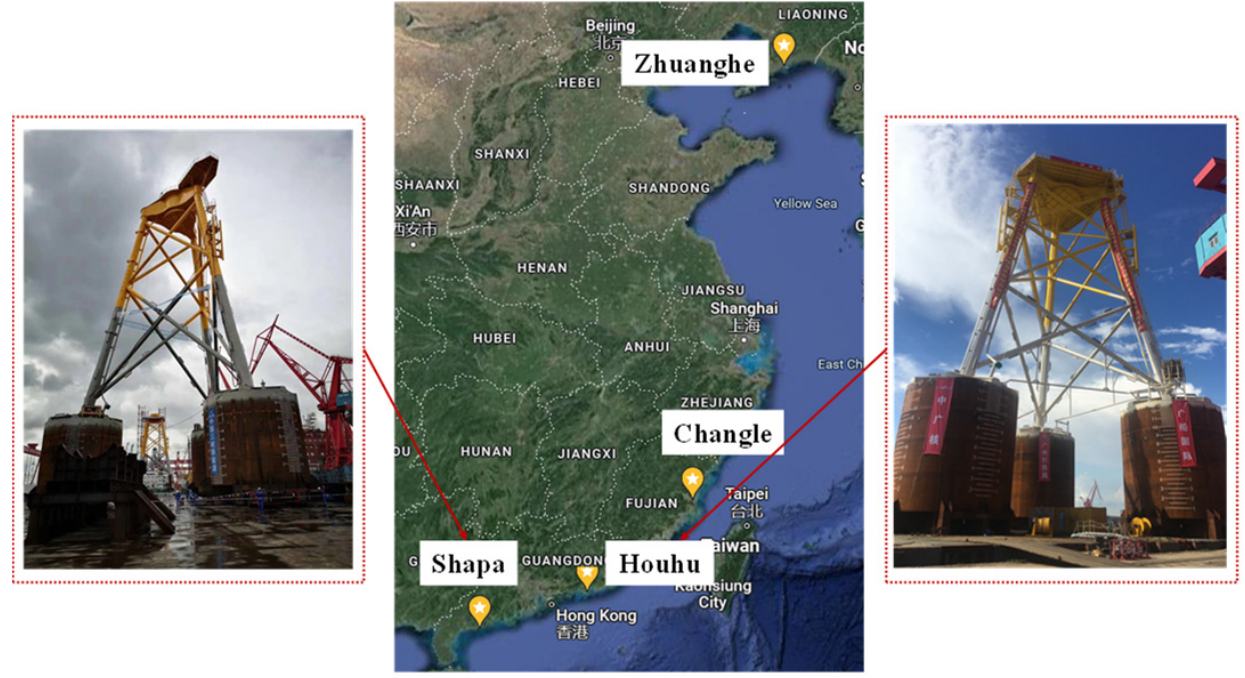
Figure 1. Application of multi-bucket jacket foundations in China. Table 1. Detailed information on multi-bucket jacket foundations installed in China.